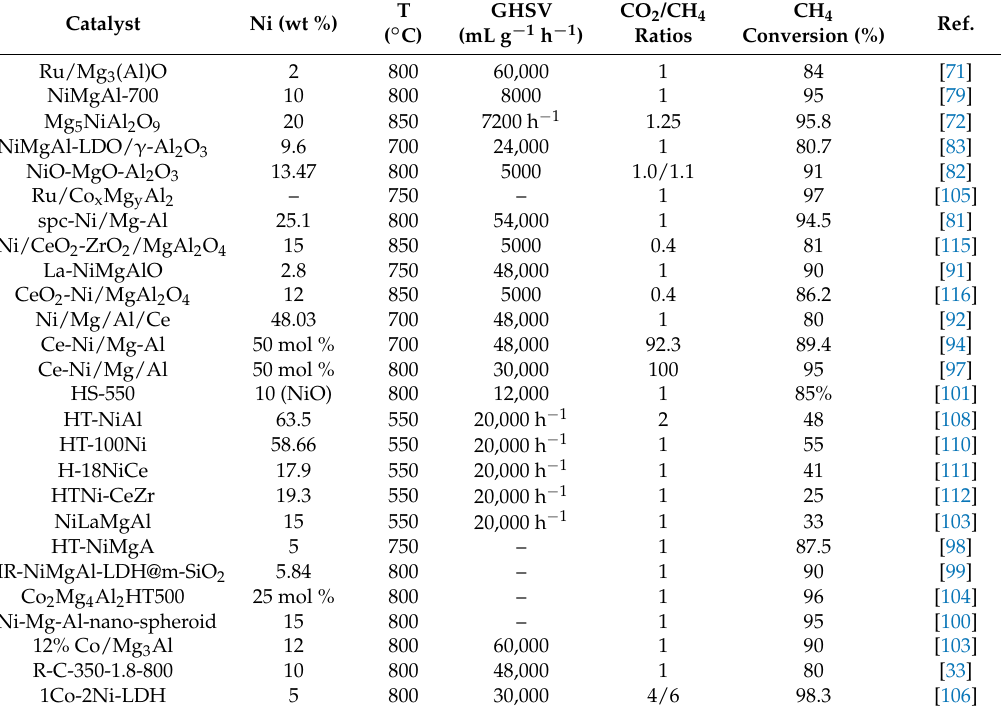
Table 3. Catalytic performance of dry reforming of CH 4 for different catalysts in different